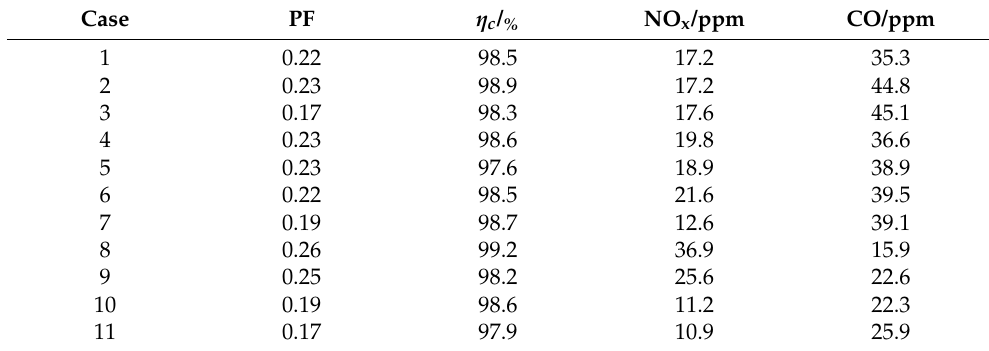
Table 5. The combustion performance for the studied cases (calculation